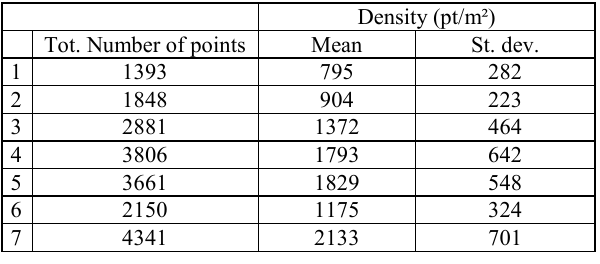
Table 4. Results of density analysis, Sample B